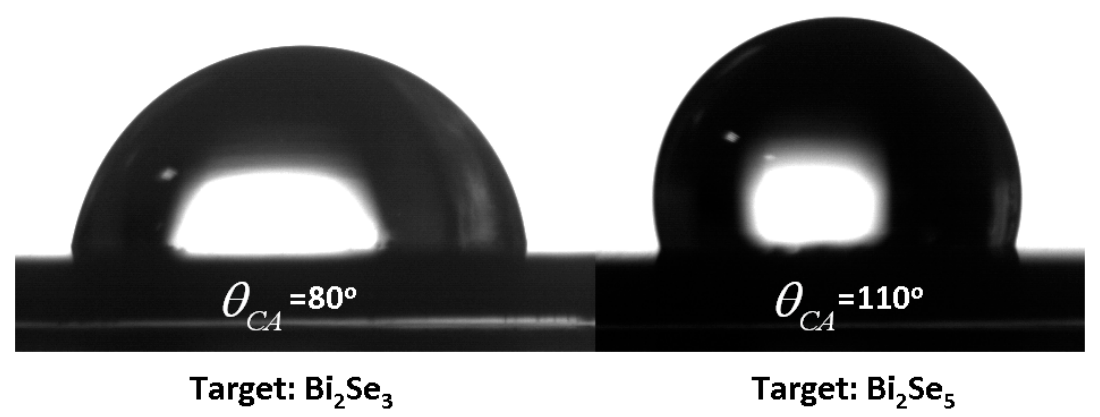
Figure 5. Contact angle test: the images of water droplets on the Bi 2 Se 3 thin film surfaces.